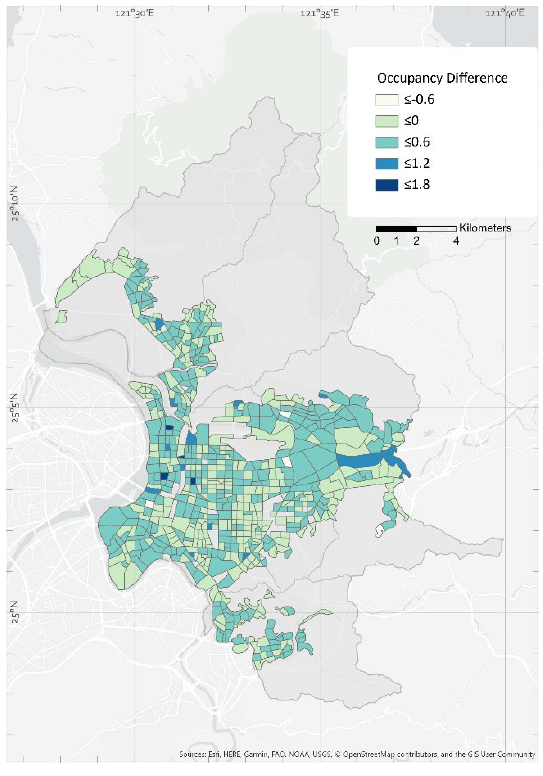
(b) Occupancy Rate